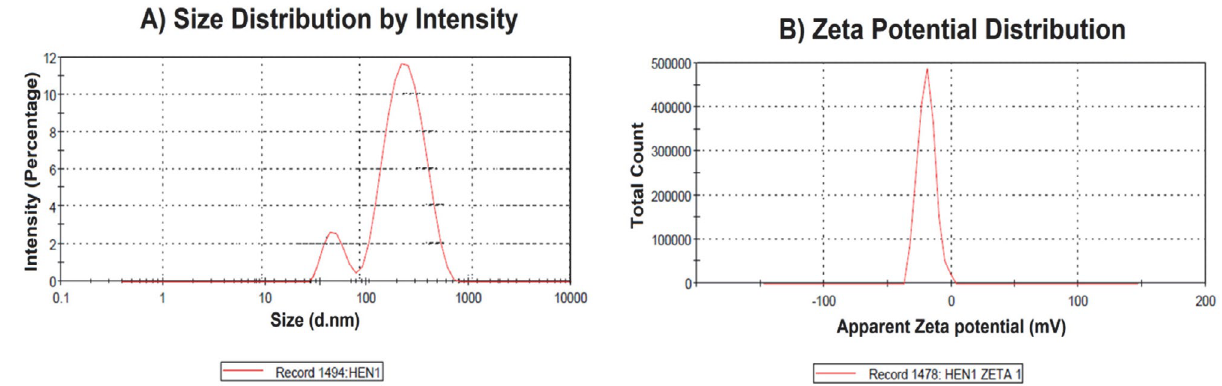
Figure 7. Graph showing: a) average particle size, b) zeta